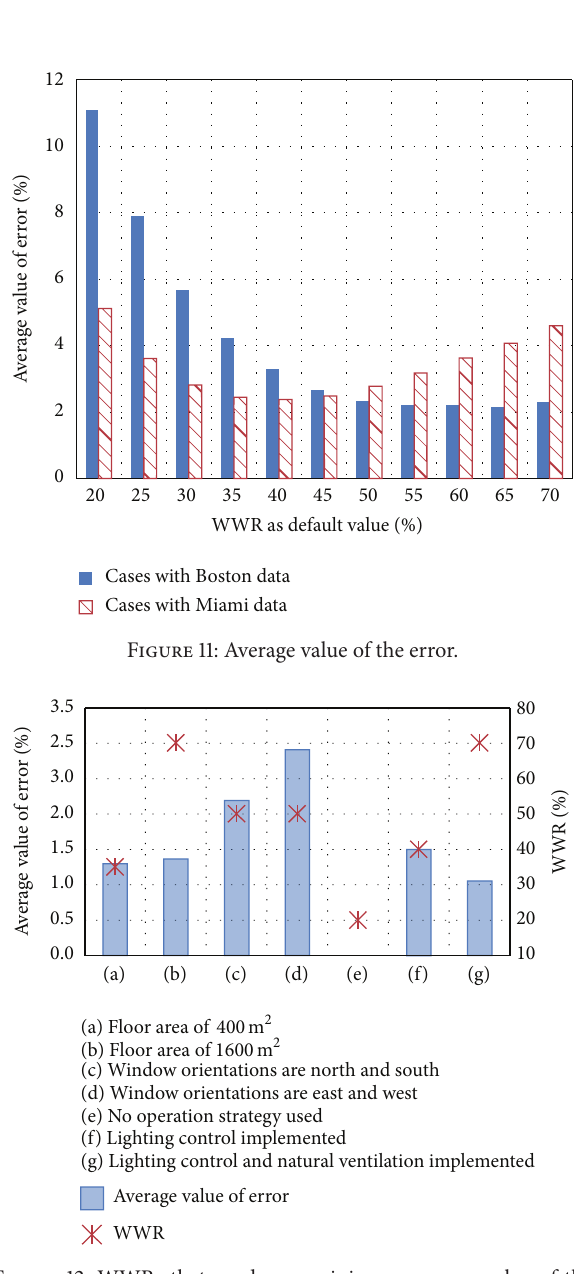
Figure 12: WWRs that produce a minimum average value of the